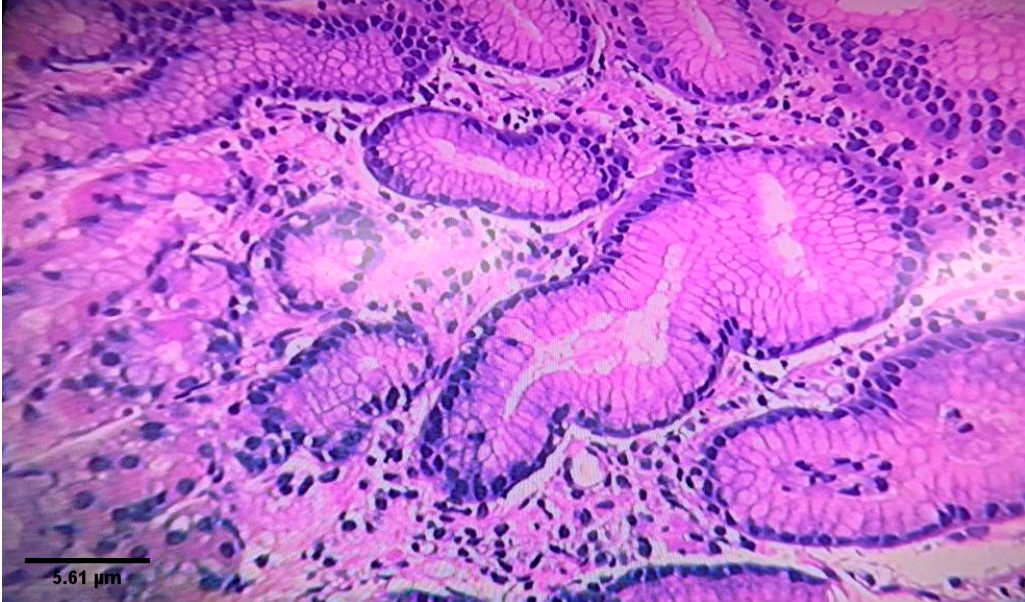
Figure 2. Gastric mucosa showing H. pylori - associated chronic active gastritis. Numerus H. pylori bacilli were observed in the lumen of a gastric pit. The lamina propria is infiltrated by mixed inflammatory cell composed mostly of neutrophils and plasma cells. There is no evidence of atrophy, granulomas, intestinal metaplasia, dysplasia and malignancy (Hematoxylin-eosin stain. Magnification ×10).